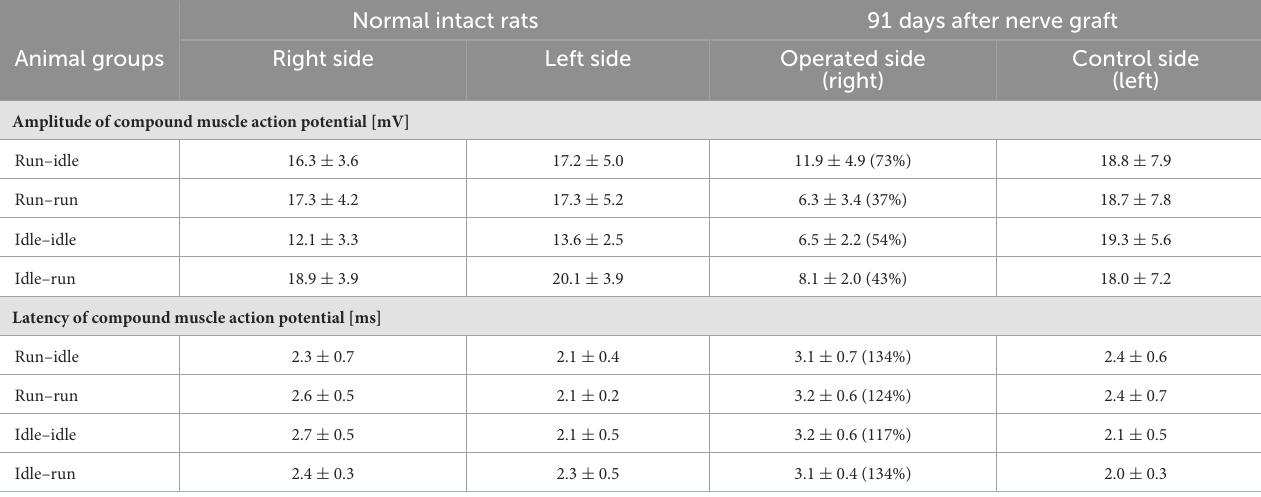
TABLE 2 Motor nerve conduction test